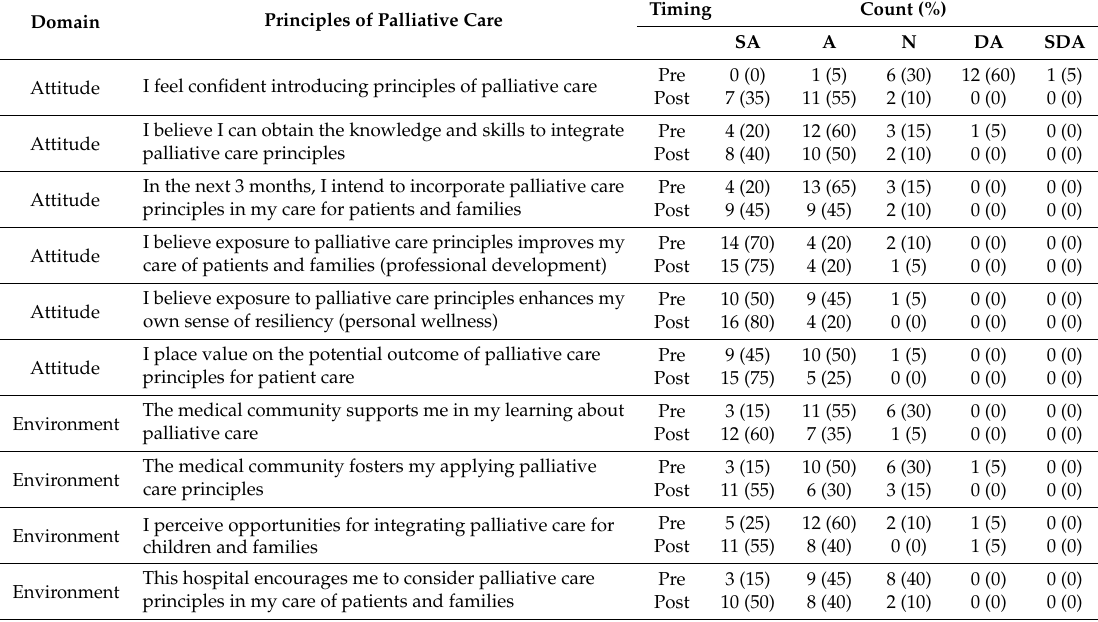
Table 1. Environment and attitude pre- and post-palliative care year-long curriculum.